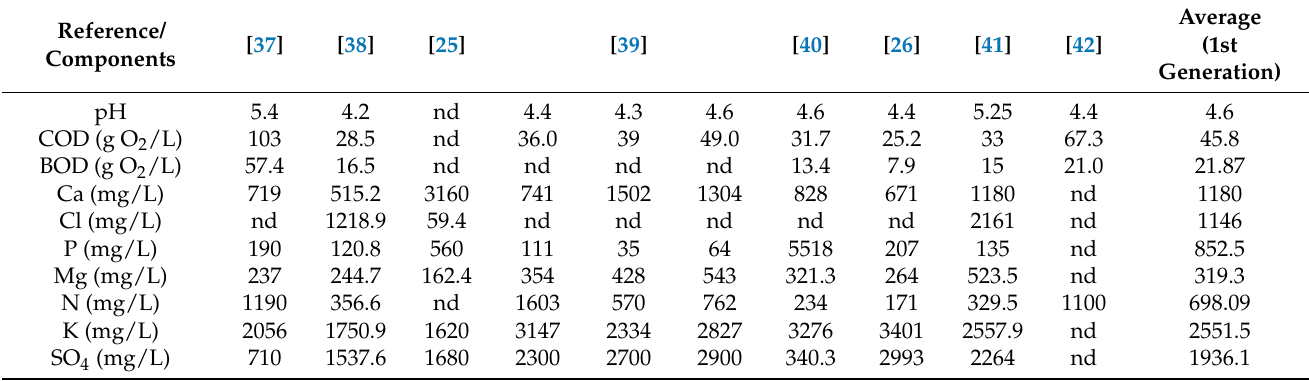
Table 1. Physicochemical composition of sugar cane vinasse before